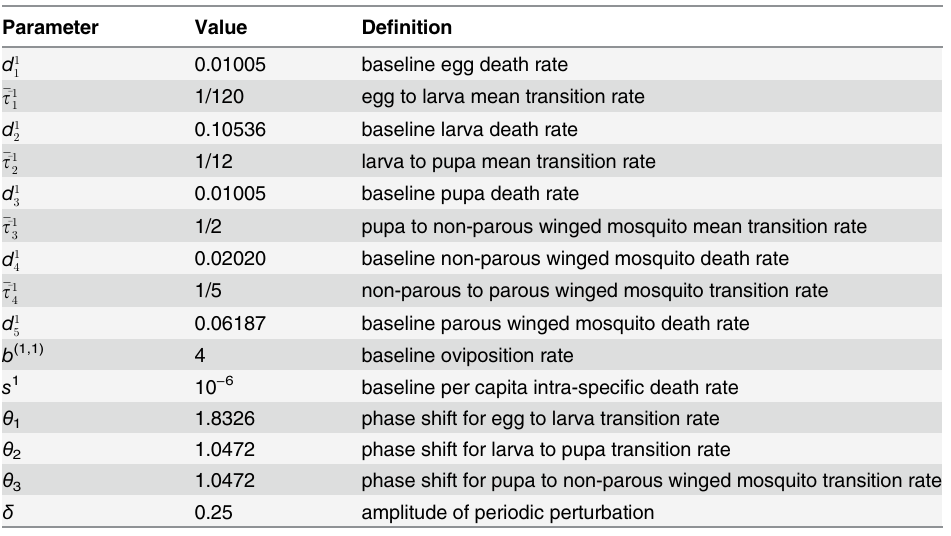
Table 1. Model parameters.